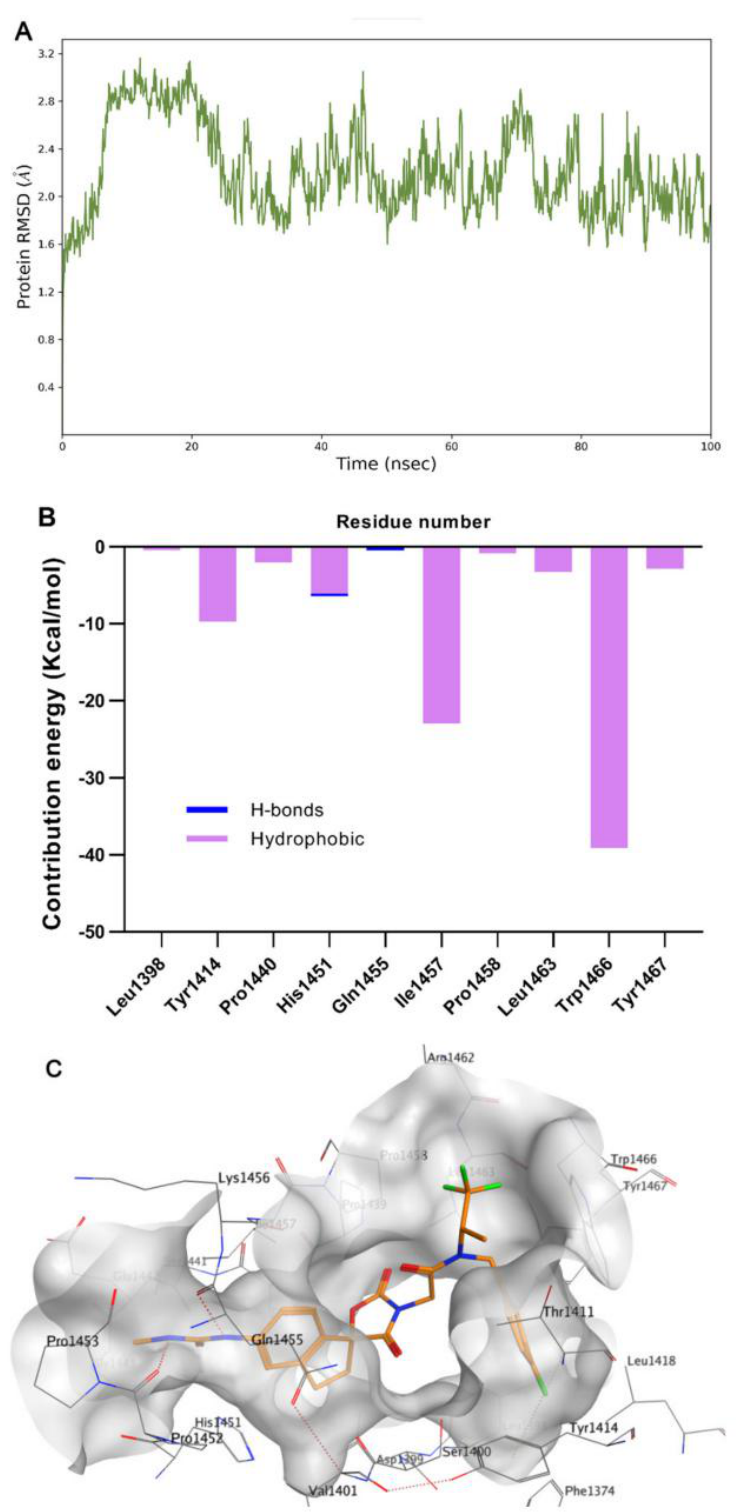
Figure 2. Molecular dynamics simulation and analysis of the interaction of A-485 with p300/CBP HAT domain. ( A ) RMSD of HAT backbone during the simulation time. ( B ) The residue contribution for protein-ligand interaction (blue: hydrogen bonds; purple: hydrophobic contacts). ( C ) Surface and interaction of the complex. (PDB code: